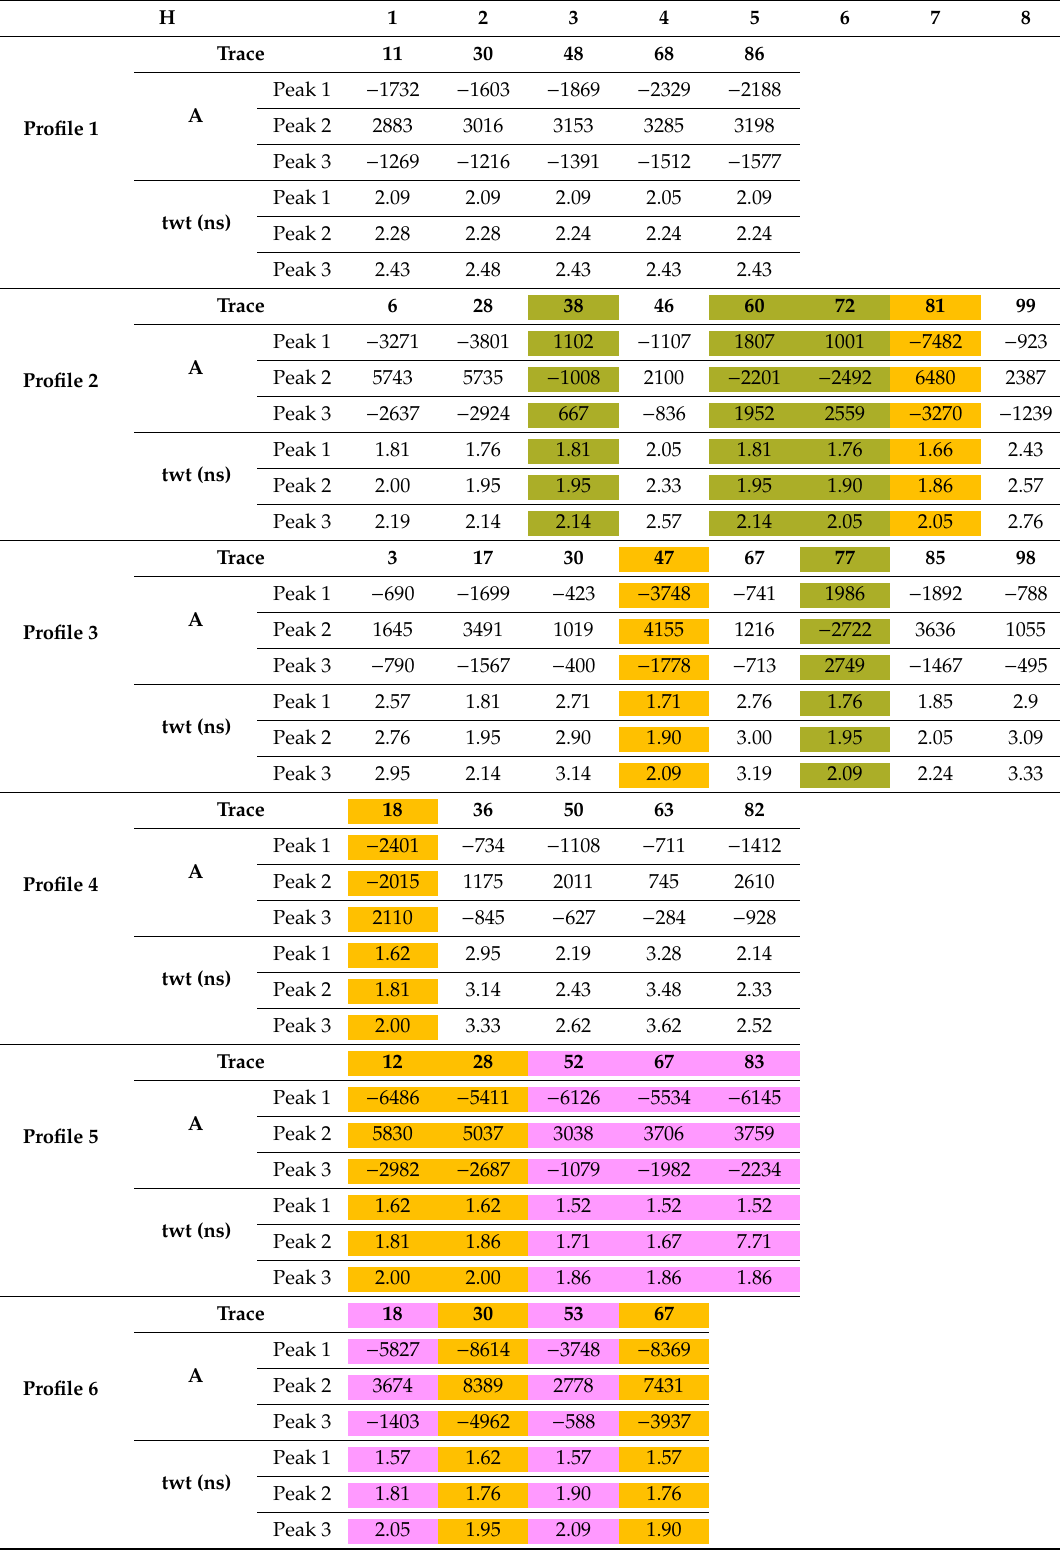
Table 3. Amplitude (A) values and travel-time distances (twt) measured on the traces where the main focuses of the hyperbolas were registered. The numbering of the hyperbolic reflections (H) and the colors are in concordance with those in Figures